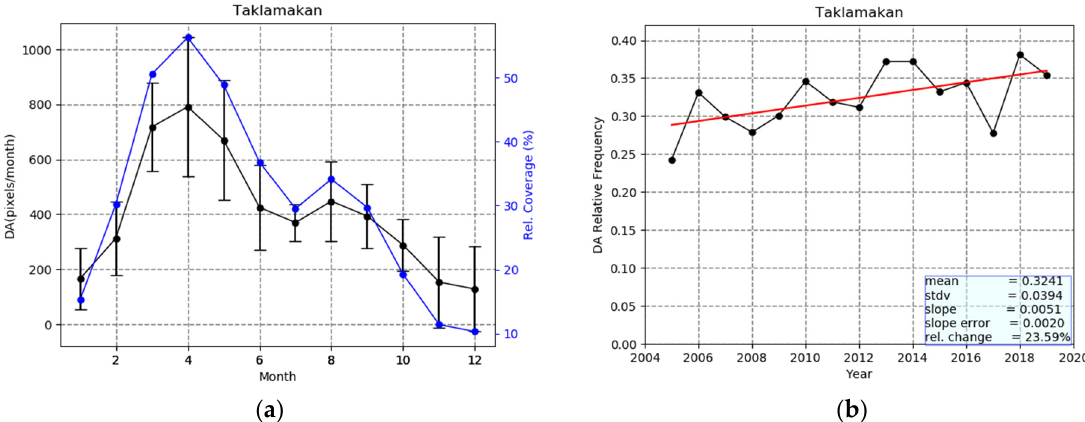
Figure 13. ( a ) Intra-annual variability of the 2005–2019 averages of the total absolute number of grid cells (1° × 1°) where dust aerosols (DA) were detected over Taklamakan by the satellite algorithm (left axis) and the percent coverage of the region by dusty grid cells (right axis). The error bars represent the year-by-year variability by means of computed 2005–2019 standard deviations. ( b ) Inter-annual variability and linear trend of the relative frequency of dust aerosols (DA) over Taklamakan.